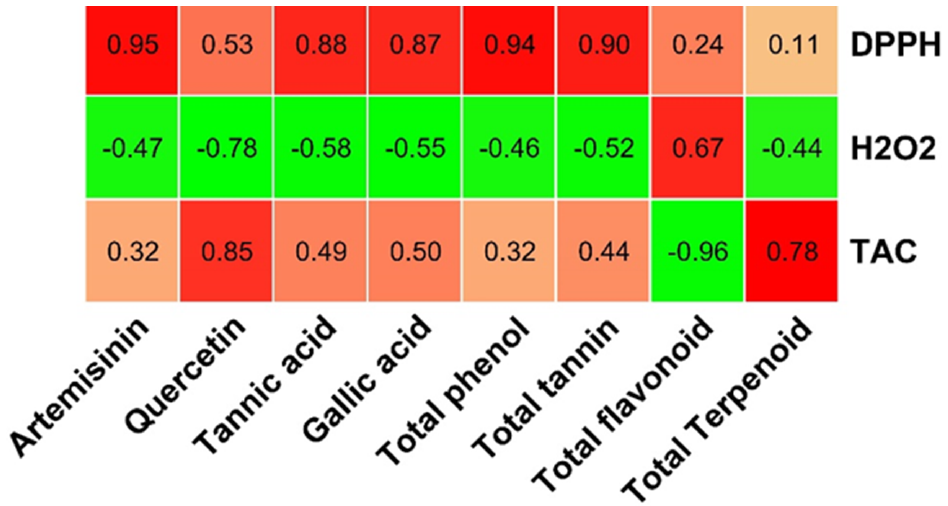
Figure 8. Relation between bioactive compounds and antioxidant assay.